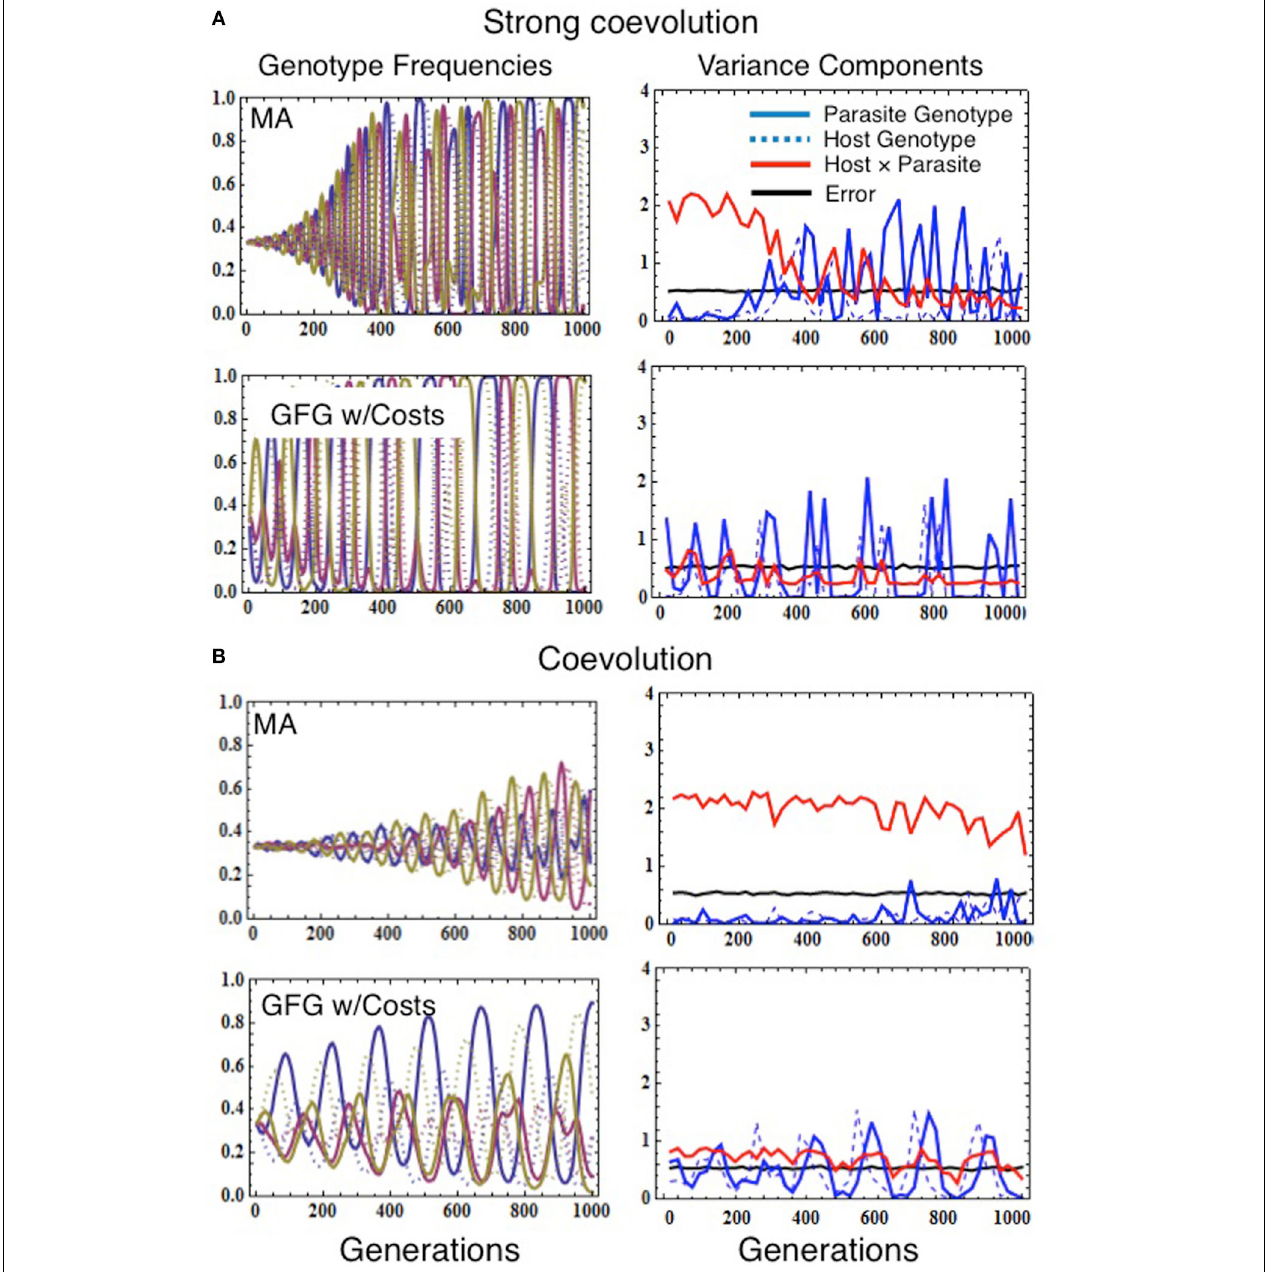
FIGURE 2 | Simulations demonstrating how the various models of infection genetics (matching alleles vs. gene-for-gene) affect population allele frequencies (left column) and variance components estimated from simulated cross-infection studies (right column), in the presence of coevolution. Evolutionary simulations assumed the population size of both host and parasite was 100,000, the mutation rate for both species was 1 × 10 − 5 , the number of genotypes in both host and parasite was 3, and that the fitness consequences of interactions were set to s h = 0 . 67 and s p = 0 . 69